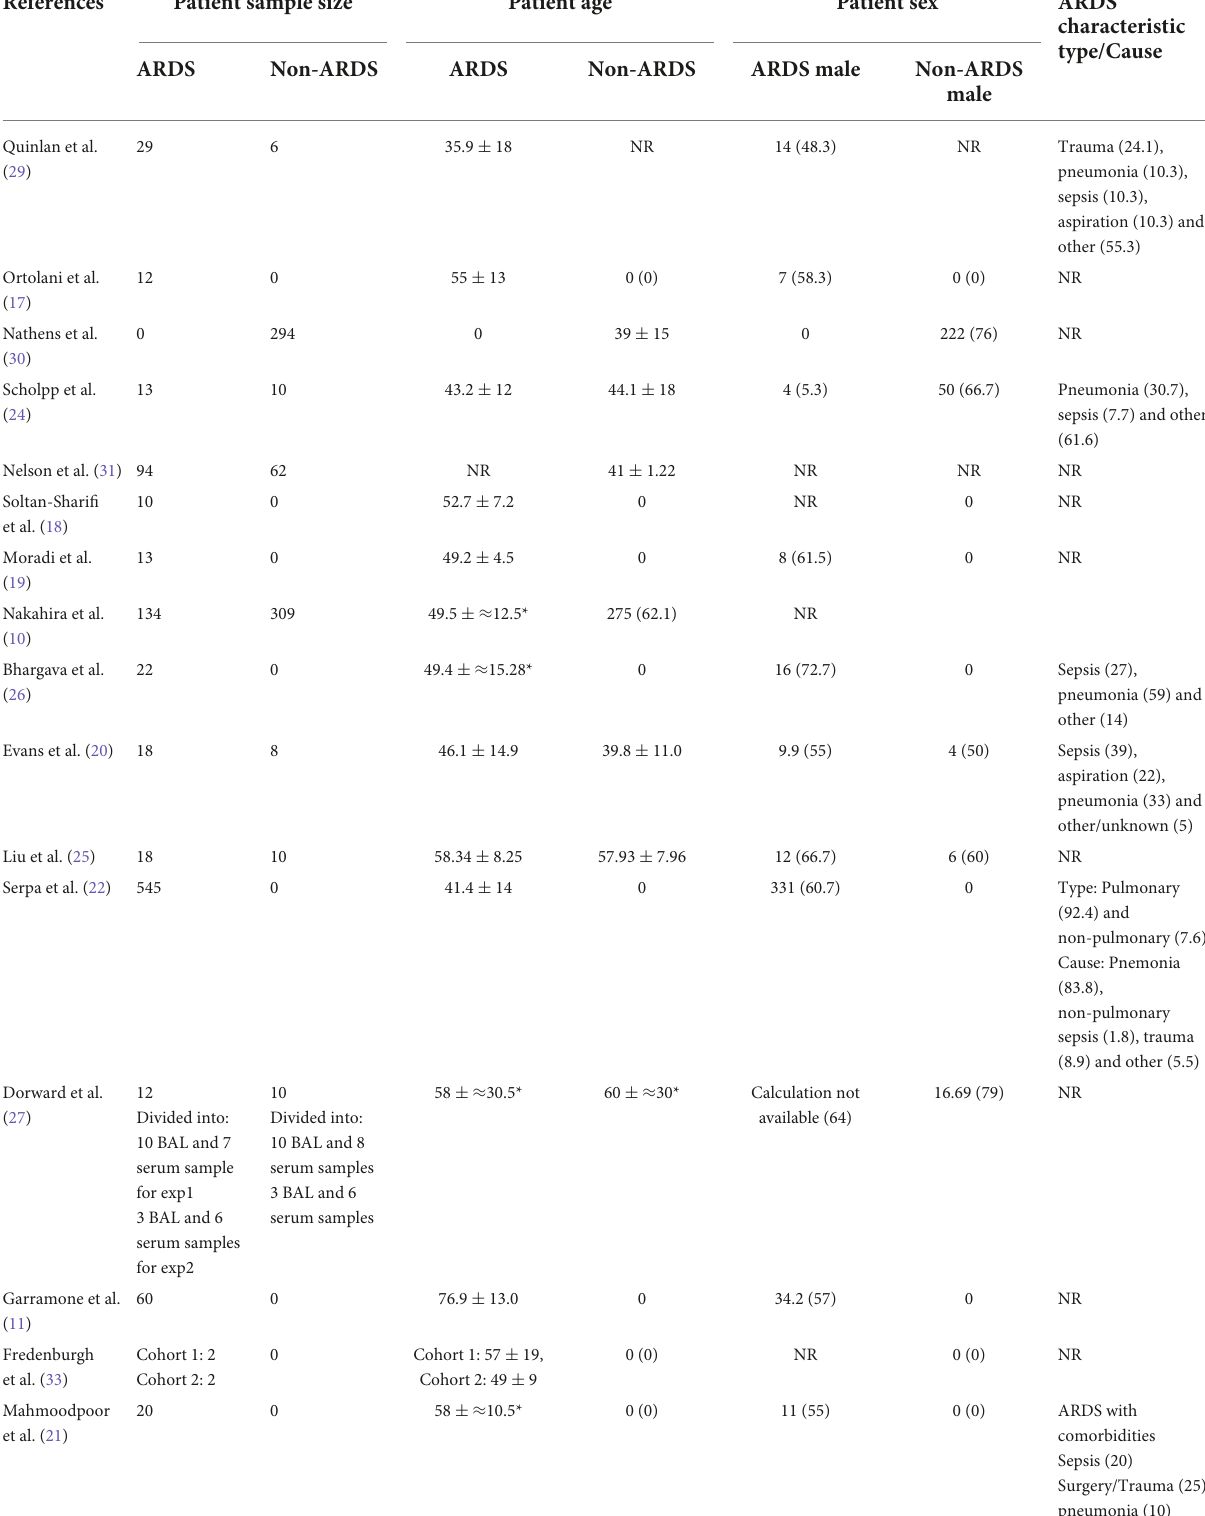
TABLE 2 Summary of patient